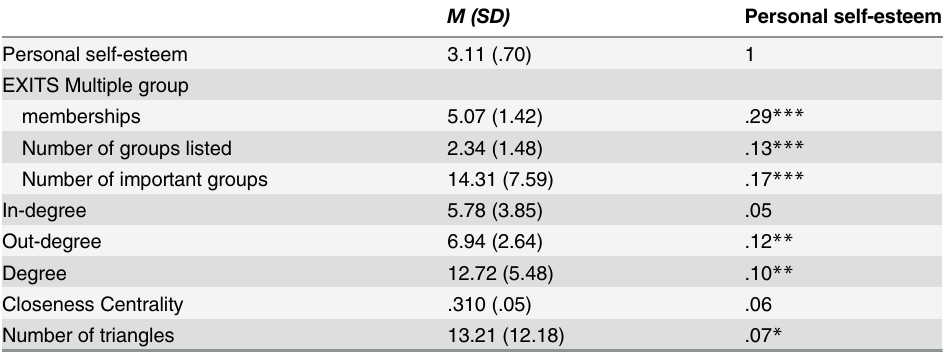
Table 4. Study 2: Descriptive statistics and bivariate correlations, for children/adolescents in a boys ’ school in